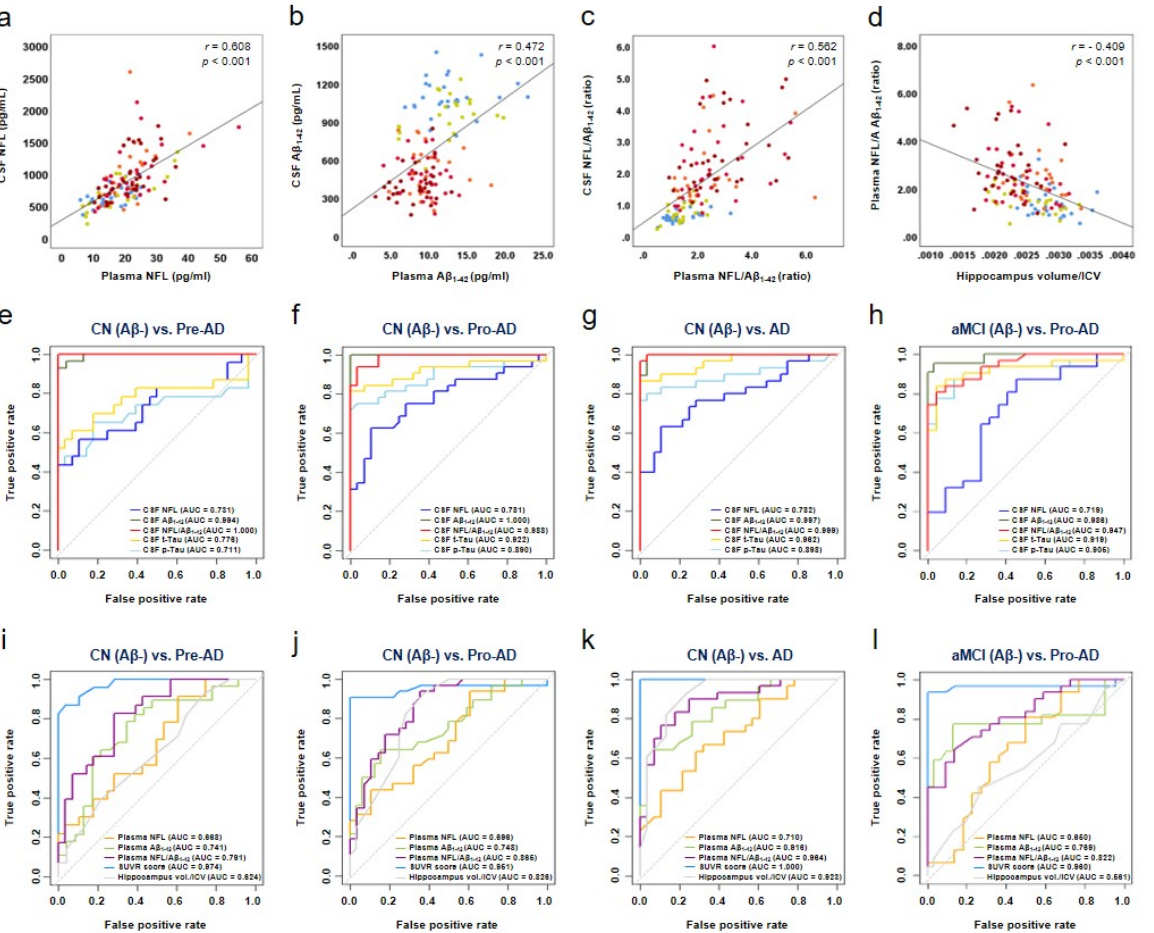
Figure 2. Correlation analysis, ROC curves, and biomarker dynamics. Pearson’s correlation analysis was used to analyse the correlations among CSF neurofilament light chain (NFL) and plasma NFL concentrations ( a ), CSF A β 1–42 and plasma A β 1–42 concentrations ( b ), CSF NFL/A β 1–42 and plasma NFL/A β 1–42 ( c ), and plasma NFL/A β 1–42 and hippocampal volume/intracranial volume (ICV) ( d ). Representative ROC curves and AUC values are shown for indicated diagnostic groups ( e l ). CSF and plasma biomarkers and neuroimaging dynamics as the standard uptake value ratio (SUVR) scores. Symbols: sky blue circle, CN(A β− ); orange circle, Pre ‐ AD; light green circle, aMCI(A β− ); red circle, Pro ‐ AD; dark red circle, AD.